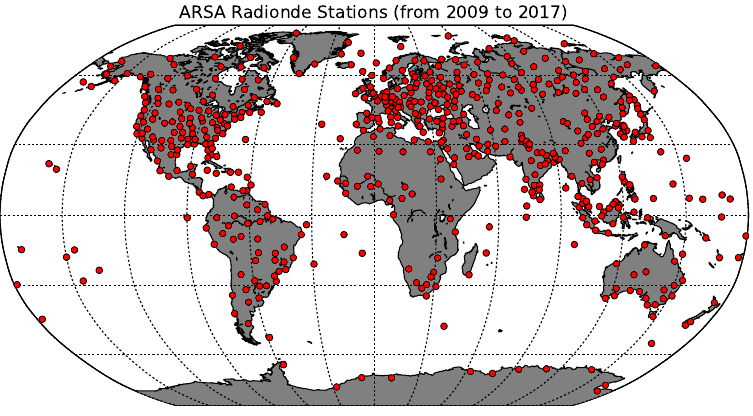
Figure 5. Global distribution of ARSA radiosonde stations between January 2009–December 2017. These locations were used to first extract GOSAT overpasses that fell within the collocation criteria. In total 1,744,215 ARSA profiles are available from 582 sites within the 8 year analysis